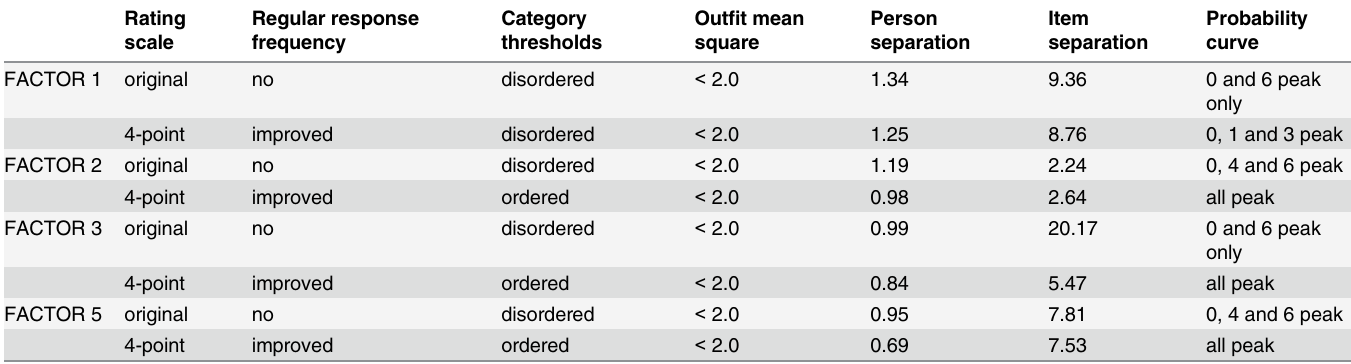
Table 2. Rating scale diagnostics, reliability indices and visual inspection of probability curves for original and collapsed 4-point rating scale. Rating